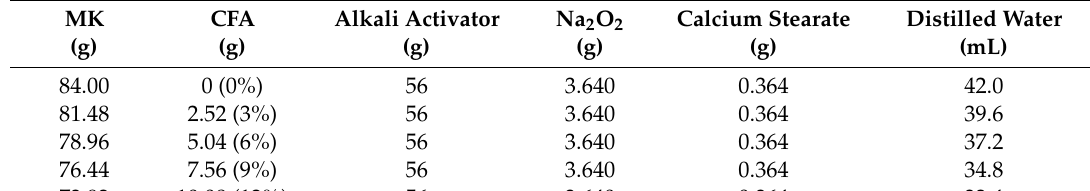
Table 2. Mix design of the CFA-MK-based GFs.